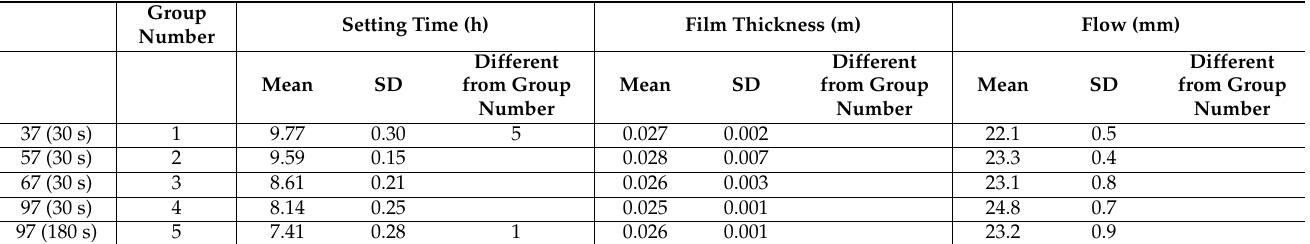
Table 5. Physical properties in accordance with ISO 6876 of AH Plus (means and standard deviations (SD)) after thermal treatment. Statistical analysis of setting time, film thickness, and flow for AH Plus was performed by Kruskal–Wallis test ( p <